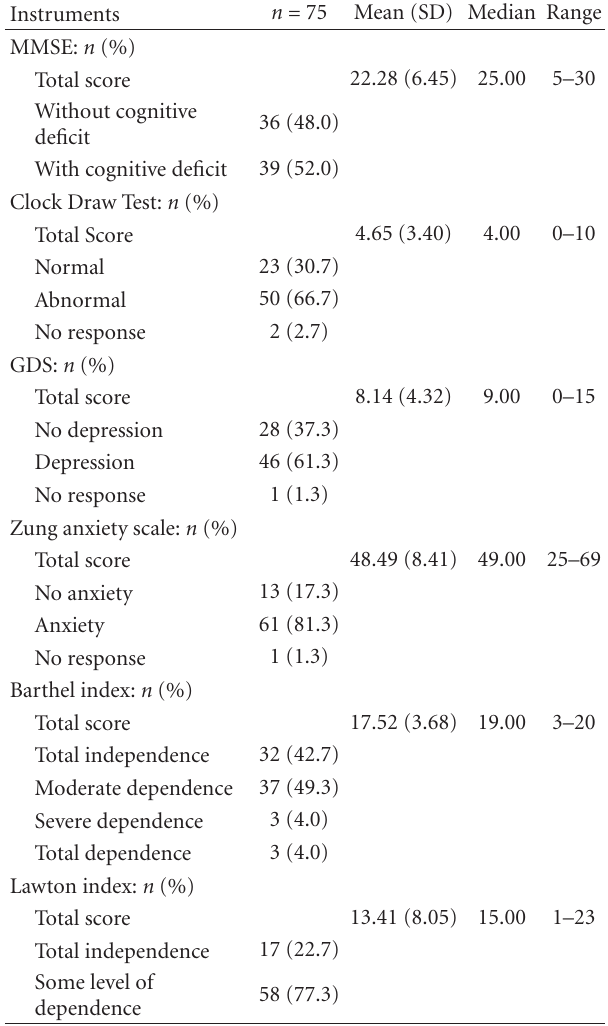
Table 3: Overall results of the instruments